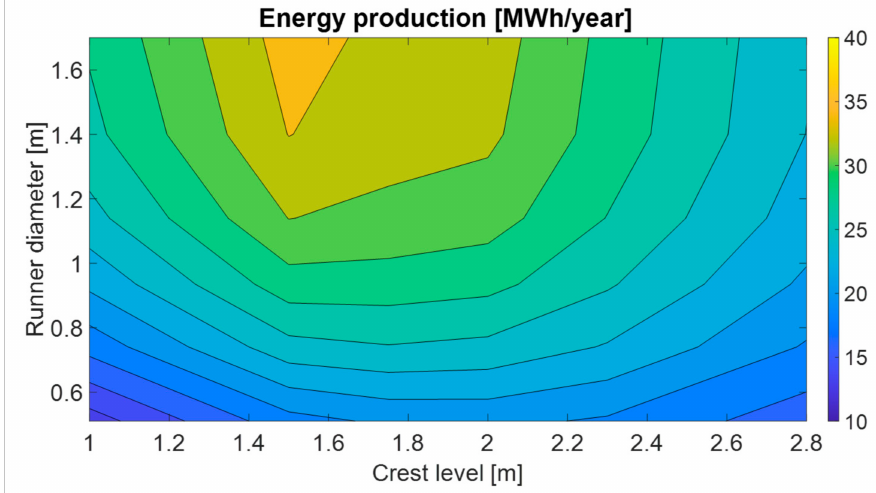
Figure 13. Energy production as function of the crest level and turbine runner